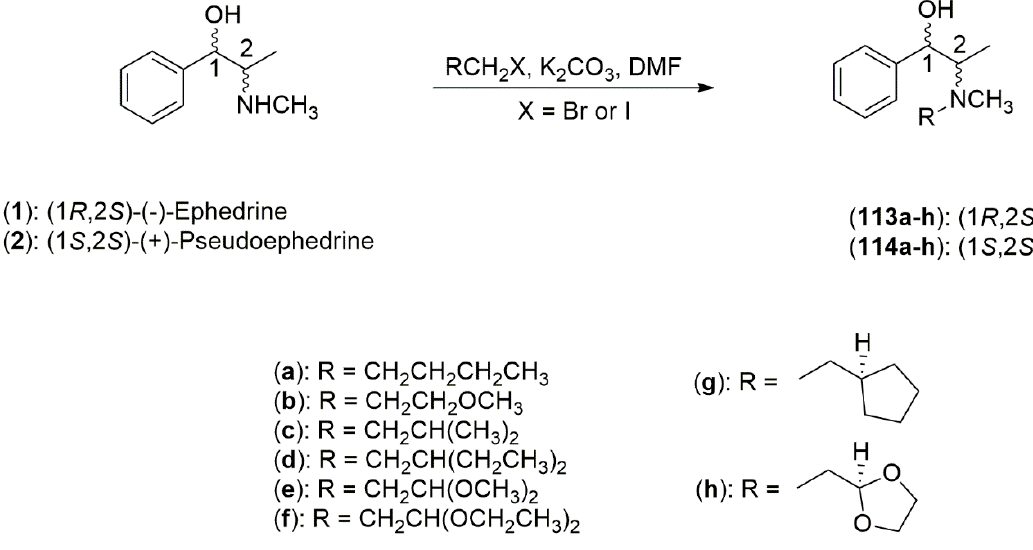
Figure 5. Synthesis of N -alkyl and N - β -alkoxyalkyl Ephedra ligands 113a – h and 114a – h .